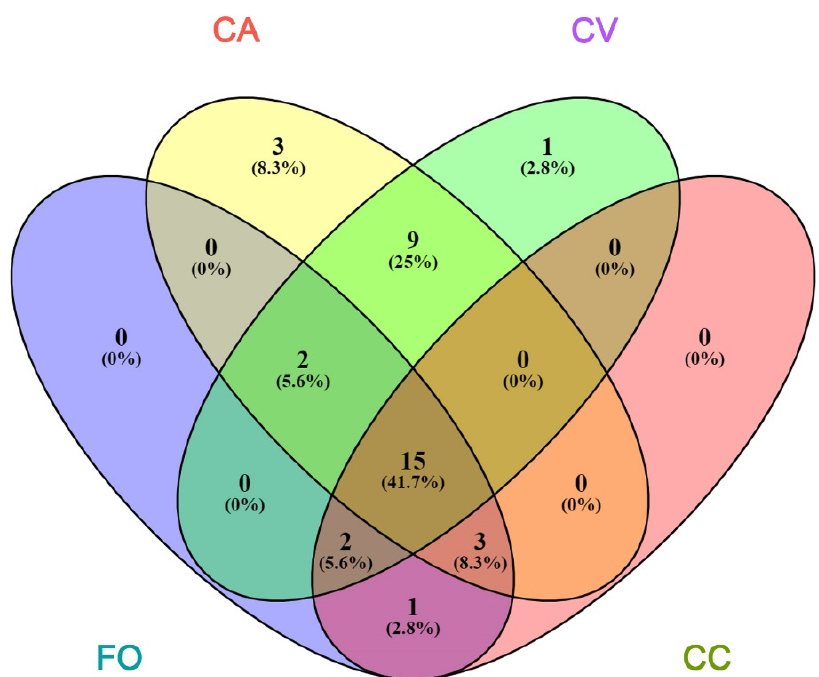
Figure 1. Biplot of the principal component analysis (PCA) for VOC profiles detected on Citrus varieties showing different susceptibilities to CTV infection. Based on their profiles, samples were organized in four groups, and the associated com- pounds to varieties separation are indicated by vectors in the plot, underlining their significance values (0.6 < cos2 < 0.9). Each main category is highlighted with a different color: aldehyde (red), monoterpene (green), and sesquiterpene (blue). CV: Citrus volkameriana ; FO: Forner-Alcaide no. 5; CC: Carrizo citrange; CA: Citrus aurantium .